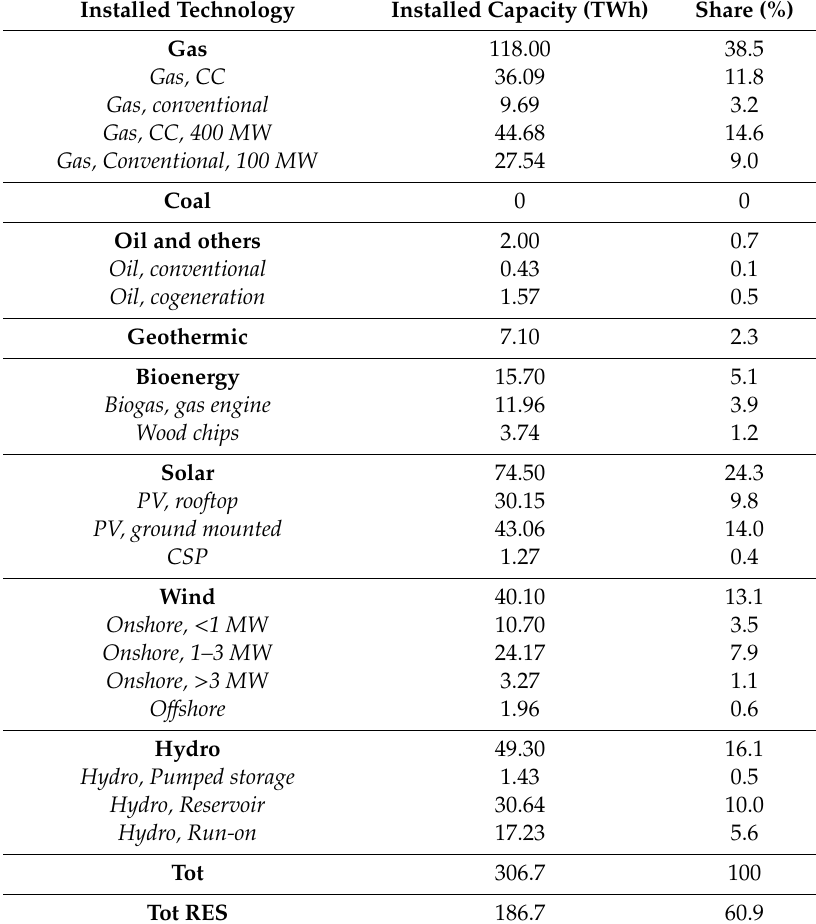
Table 2. Italian 2030 energy mix for electricity production (TWh). CC = Combined Cycle; CSP = Concentated Solar Power; PV = Photovoltaics; RES = Renewable Energy